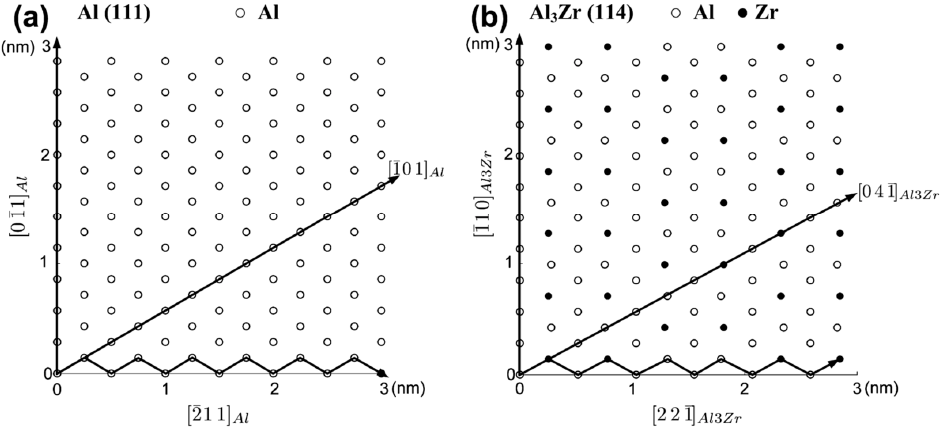
Figure 4. Schematic diagram of the arrangement of atoms [28]: ( a ) Al, ( b ) Al 3 Zr. Reprinted with permission from [28], 2013, Elsevier.